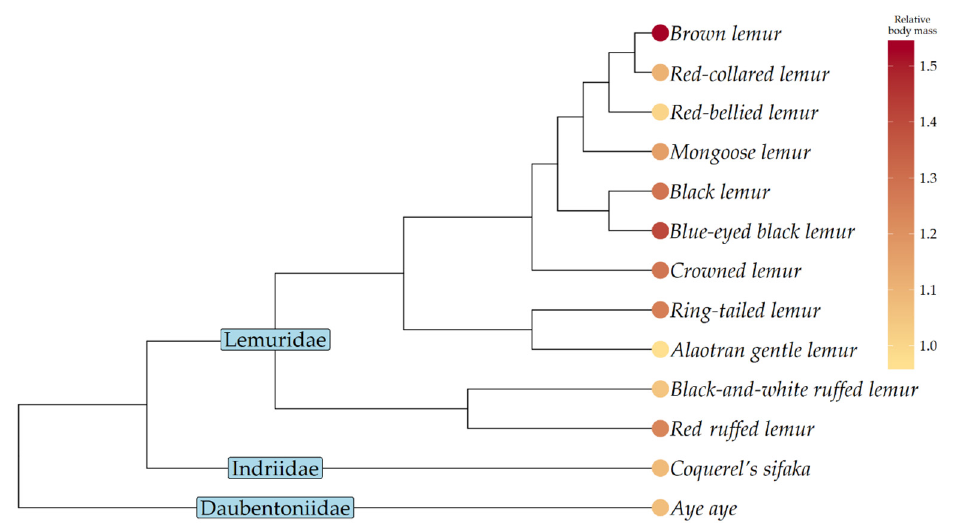
Figure 3. Phylogenetic tree of 13 lemur species in our comparative analyses, with their species-typical median relative body mass values shown as tip-points. The colour of a species’ tip-point represents its species-typical body condition: the healthy range (species-typical relative body mass 0.75–1.25) is shown by yellow shading; overweight by orange (1.25–1.5); obese by red (1.5–2); and morbidly obese (>2) by the darker red.